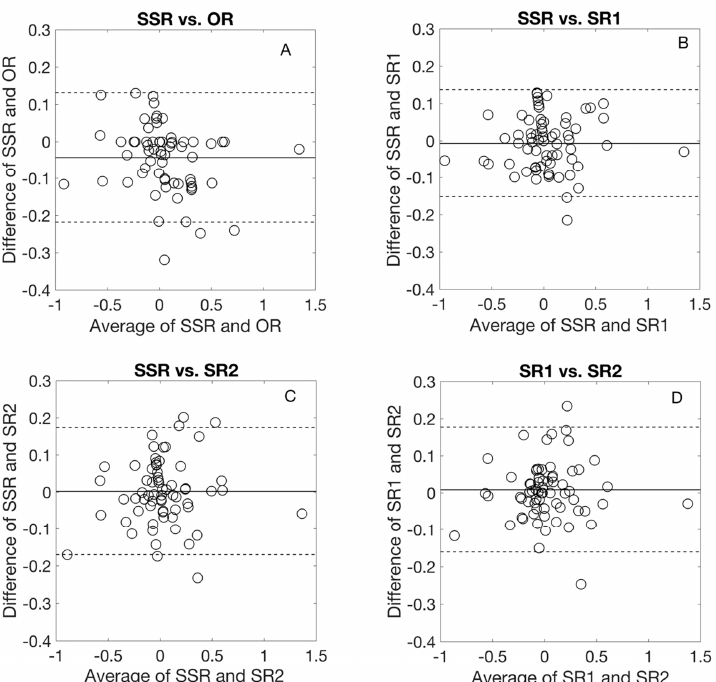
Figure 2. Bland-Altmann comparison for cylindrical component, J 0 among different refraction procedures. The middle line represents the average difference, the dashed lines represent 95% limits of agreement. OR: Objective refraction, SSR: Standard subjective refraction, SR1 and SR2: the two algorithm-based subjective refraction procedures. J. Clin. Med. 2020 , 9 , x FOR PEER REVIEW